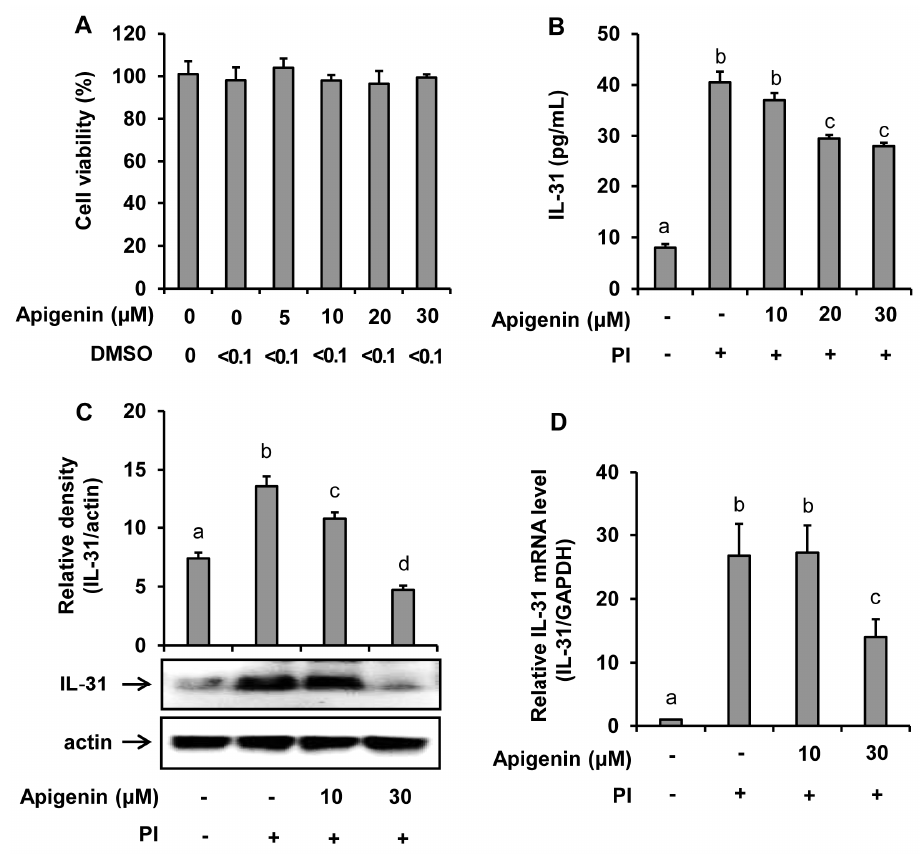
Figure 1. Effects of apigenin on the human mast cells (HMC-1) viability and IL-31 production by HMC-1. Cells were pre-treated with apigenin at indicated concentrations for 24 h. Cell viability was determined by EZ-Cytox assay ( A ). Cells were pre-treated with apigenin at indicated concentrations for 1 h prior to PI stimulation for 12 h ( B ), 6 h ( C ), and 3 h ( D ). ELISA was used to measure IL-31 released in the cell culture media ( B ). Western blot analysis was used to determine the IL-31 protein expression levels in the cells and the bands were quantitated using Image J analysis software tool ( C ). Reverse-transcription (RT)-PCR was performed to determine the level of expression of IL-31 mRNA in the cells ( D ). The values presented are the means ± SD of three independent experiments. Bars with different small case letters indicated statistically significant difference at p < 0.05. PI, phorbol-12-myristate 13-acetate (50 nM) and ionomycin (1 μM).